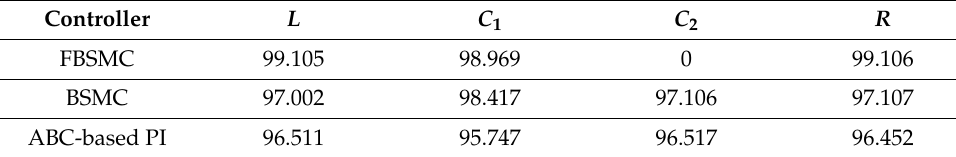
Table 7. Dynamic efficiency for a 20% decrease in the system parameters.